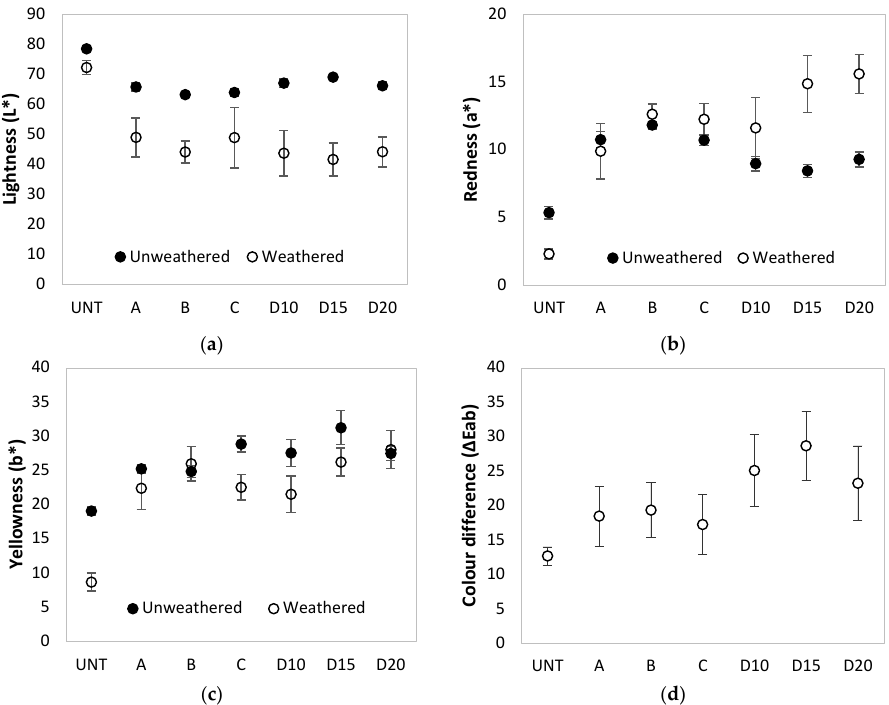
Figure 2. Changes in colour of untreated (UNT) and PF resin treated plywood after exposure to UV light and water spray after 1000 h in QUV camera: ( a ) Changes in the CIE parameter L* (lightness); ( b ) Changes in the CIE parameter a* (red-green); ( c ) Changes in the CIE parameter b* (yellow-blue); ( d ) Colour difference parameter ΔEab.